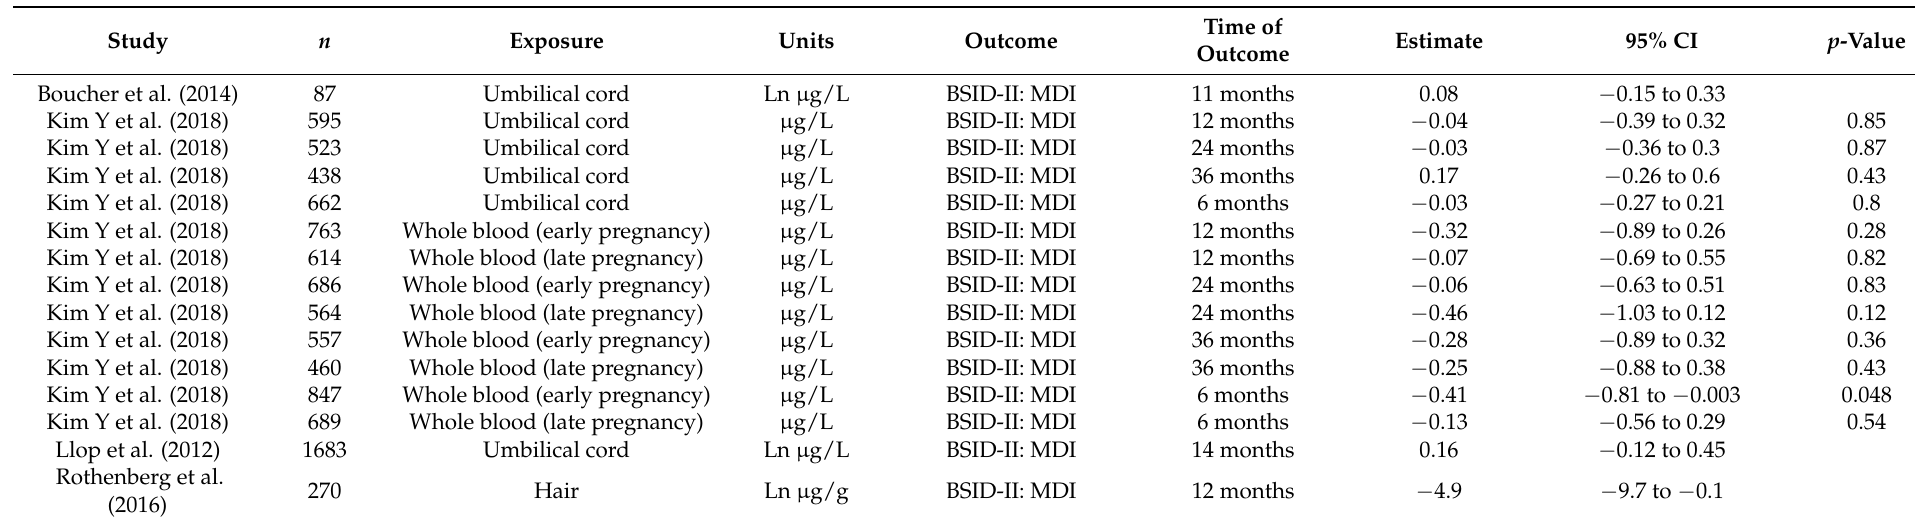
Table 4. Results from studies identified as high quality which measured cognition and language in the BSID:II MDI scale ( n =